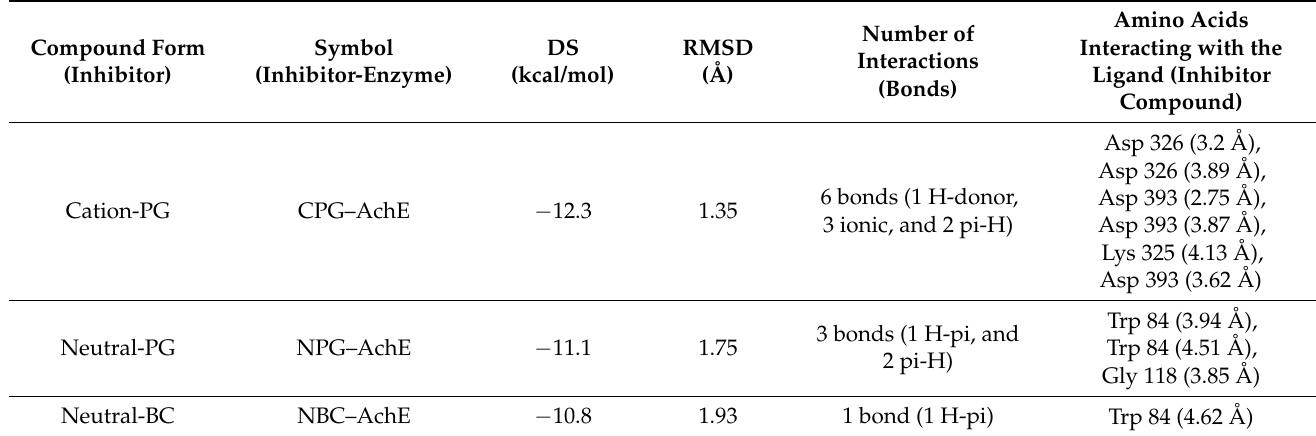
Figure 7. The 2D and 3D structures of cation-PG ( a ), neutral-PG ( b ), neutral-BC ( c ), and the AChE enzyme crystal structure ( d ). Table 2. The results of the docking simulation between cation-PG, neutral-PG, and neutral-BC with the target protein